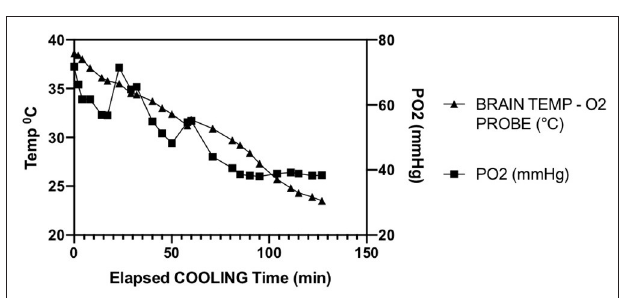
FIGURE 4 | Parallel decline in parenchymal temperature and tissue oxygen in a single animal opposite to the side of ischemia. Pearson R = 0.90.